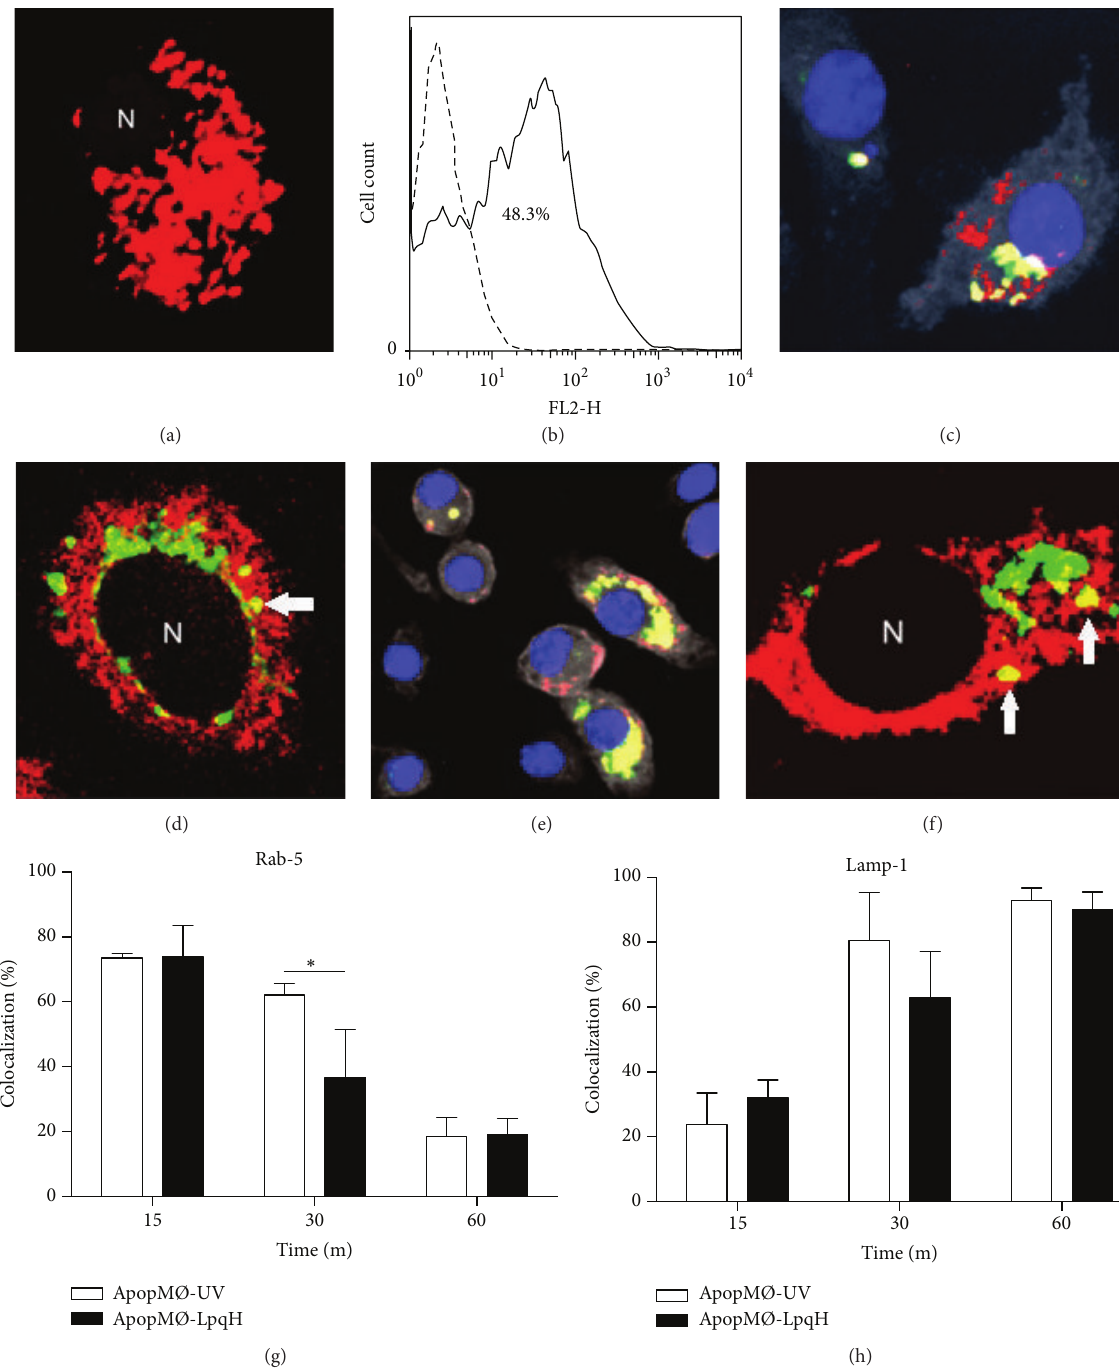
Figure 3: Phagosomes with engulfed apoptotic macrophages mature into phagolysosomes. Phagocytosis assays were conducted with J-774A.1 cellsandapoptoticMØslabeledwithpHrodo,amarkerthatemitsstrongredfluorescenceinanacidicenvironment.After24 hofphagocytosis, confocal microscopy showed numerous pHrodo fluorescent apoptotic bodies in the majority of the cells ((a), original 100x). As determined by flow cytometry, 48.3% of the cells were found to be positive for pHrodo (b). To further determine phagosome maturation, phagocytic cells were cocultured for 15, 30, and 60min with apoptotic MØs labeled green with PKH-67. The expression of the early endocytic marker Rab5 and LAMP1, a late endosome marker, was assessed by immunofluorescence. The cells were permeabilized and incubated with Cy5-labeled antibodies to Rab5 or LAMP1. In overlaid images, epifluorescence ((c), original 60x) and confocal microscopy ((d), original 100x) show cells containing yellow-fluorescent vesicles, indicating the colocalization of Rab5 with PKH-67-labeled apoptotic bodies. The colocalization of LAMP1 and engulfed apoptotic MØs was also demonstrated (e and f). As expected, the recruitment processes of Rab5 and LAMP1 followed inverse time courses (g and h). The results of three independent experiments are shown. Student’s 𝑡 -test was used to assess the statistical significance. ∗ 𝑝 < 0.05 . N,